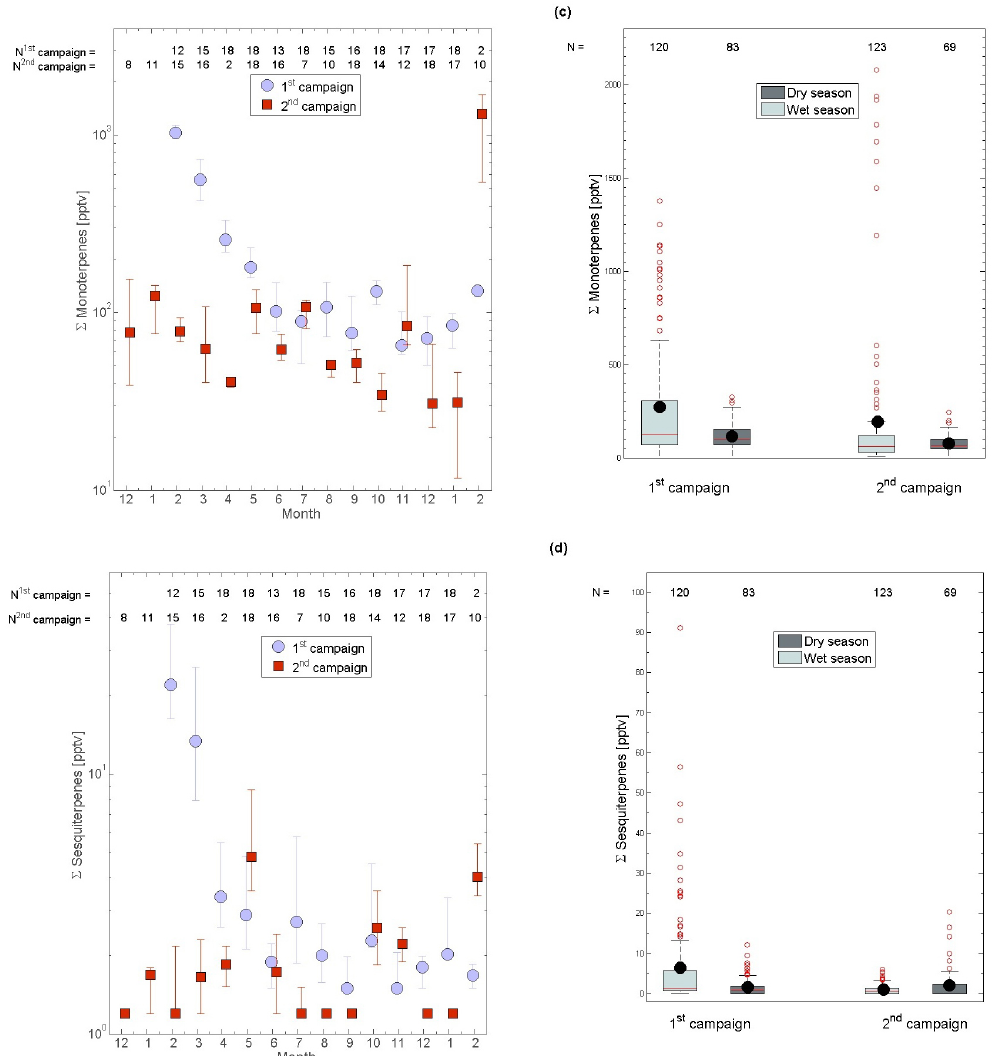
Figure 5. The panels on the left show monthly median concentrations of (a) isoprene, (b) MBO, (c) monoterpene and (d) SQT measured for the two campaigns. Error bars indicate upper and lower quartiles. The values displayed near the top of the graphs indicate the number of samples (N 1st and N 2nd campaign) analysed for each month. The panels on the right show the wet and dry season concentrations of the respective compounds measured for the two campaigns. The red line of each box indicates the median (50th percentile), the black dot the mean, the top and bottom edges of the box the 25th and 75th percentiles, the whiskers ± 2.7 σ or 99.3% coverage if the data have a normal distribution and the red circles outliers of the range of the box and whisker plot. The values displayed near the top of the graphs indicate the number of samples ( N ) analysed for the wet and dry